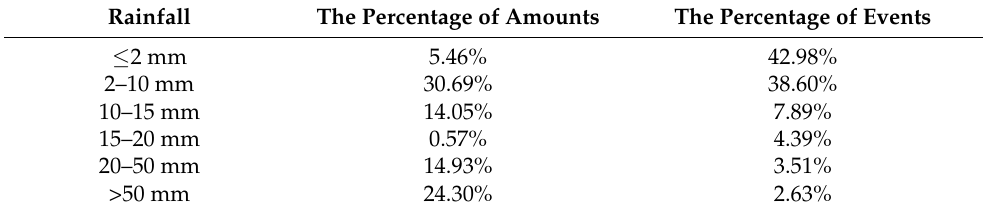
Figure 2. Seasonal course of relationship between soil moisture content and rainfall in grassland, Q. acutissima , and C. lanceolata between 9 September 2012 and 8 August 2013. Table 1. Distribution of rainfall during study